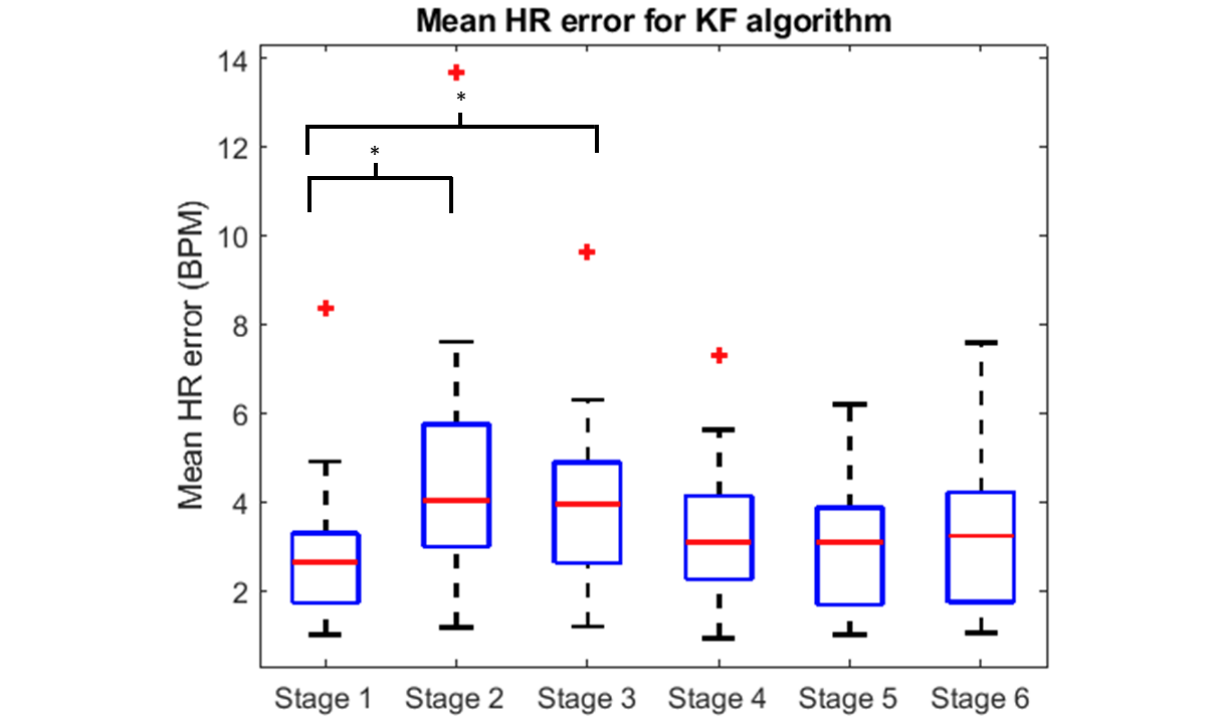
Figure 7. Mean error of the estimated heart rate from the Kalman filter. “*” indicates significant difference ( P <.05). Significance was calculated using paired one-tailed t tests. BPM: beats per minute; HR: heart rate; KF: Kalman